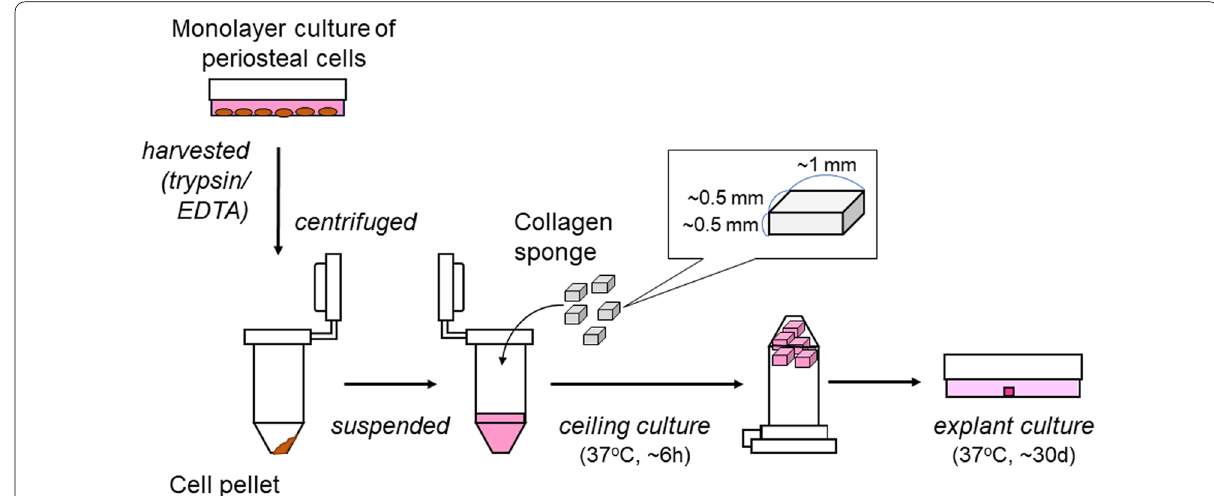
Fig. 1 Workflow diagram for the preparation of periosteal sheets using collagen